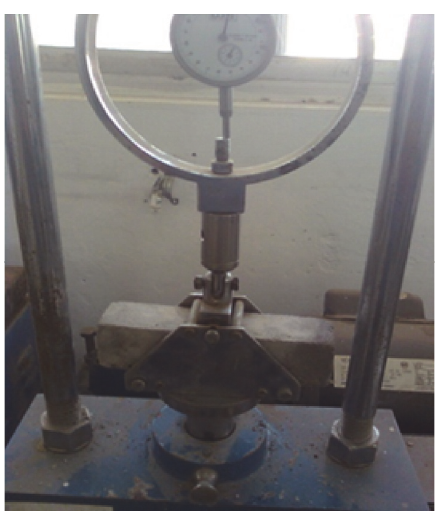
Figure 2: Flexural testing